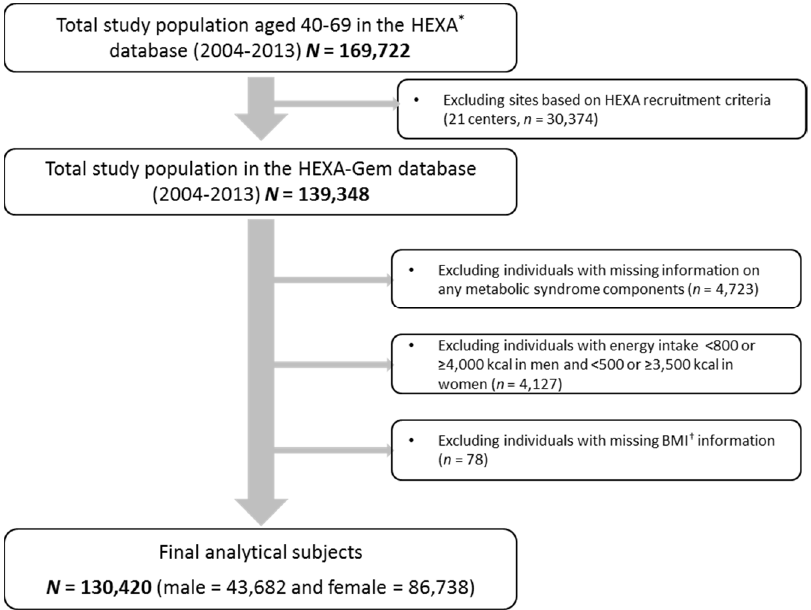
Figure 1. Flow diagram of analytical sample. * HEXA: Health Examinees, † BMI: Body Mass Index.